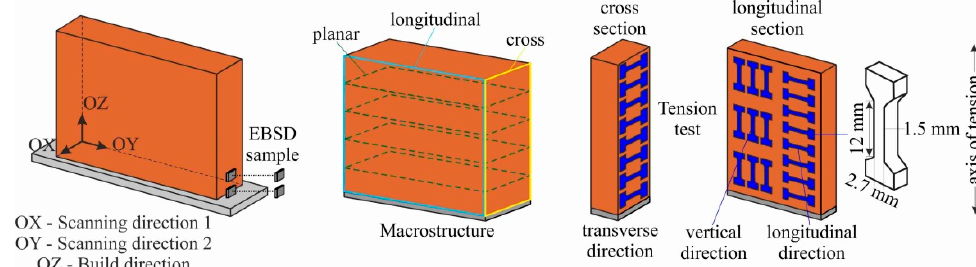
Figure 3. Scheme of cutting samples into metallographic sections and samples for mechanical testing.